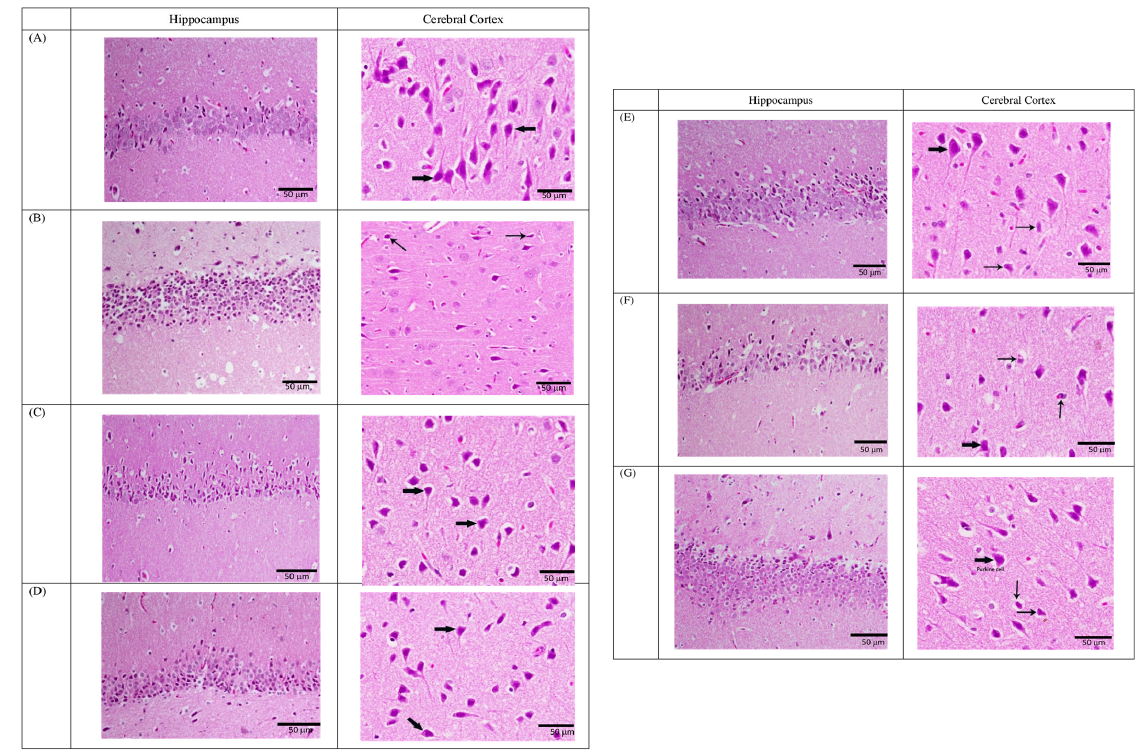
Figure 9. Histology Examination of the Brain Sections (Hippocampus and Cerebral Cortex) of the Different Rat Groups: ( A ) control group, ( B ) stressed group, ( C ) fluoxetine-treated non-stressed rats, ( D ) fluoxetine-treated stressed rats, ( E ) pre-injected LPS non-stressed rats, ( F ) pre-injected LPS stressed rats, ( G ) pre-treated fluoxetine and LPS stressed rats (Resistant Group). Each image is a representative image of the brains of five rats per group.